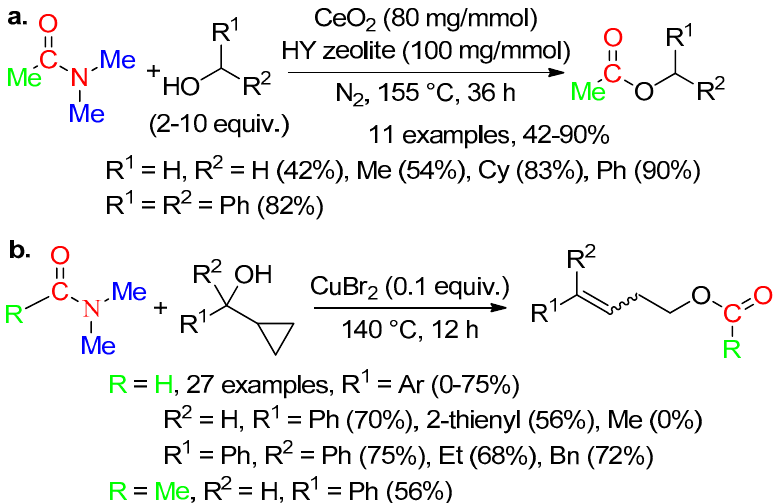
Scheme 36. CeO 2 -promoted alcoholysis of DMAc and CuBr 2 -catalyzed ring